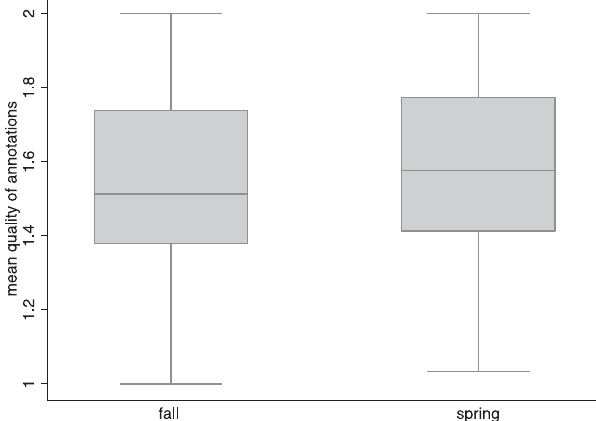
FIG. 2. Box and whisker plots depicting the distributions of annotation quality scores for students in each of the two semesters. The ends of the box are the upper and lower quartiles; the median is marked by the vertical line inside the box; the whiskers are the two lines outside the box that extend to the highest and lowest observations and, therefore, show the